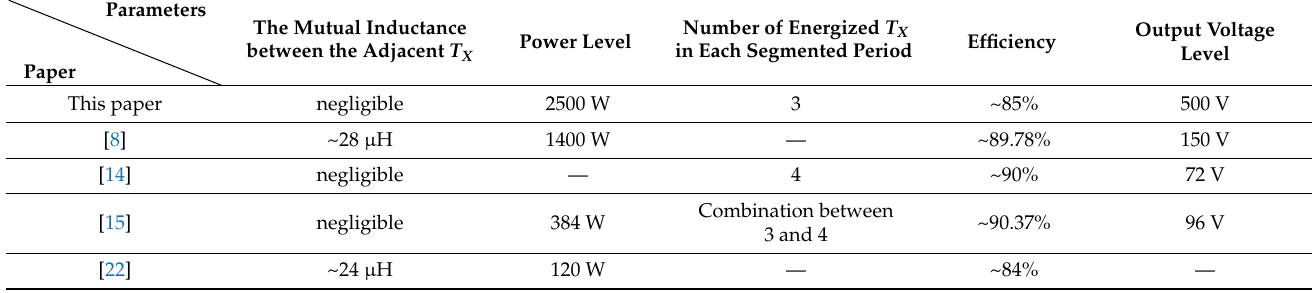
Table 3. Benchmarking among several segmented DWPT